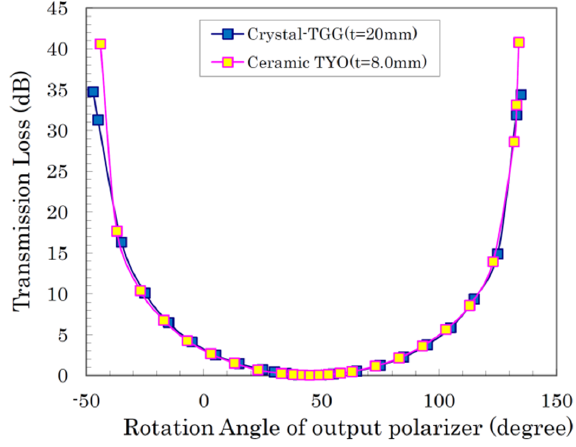
Figure 6. Faraday rotation characteristics of the TYO ceramics in comparison with those of the commercial TGG single crystal.